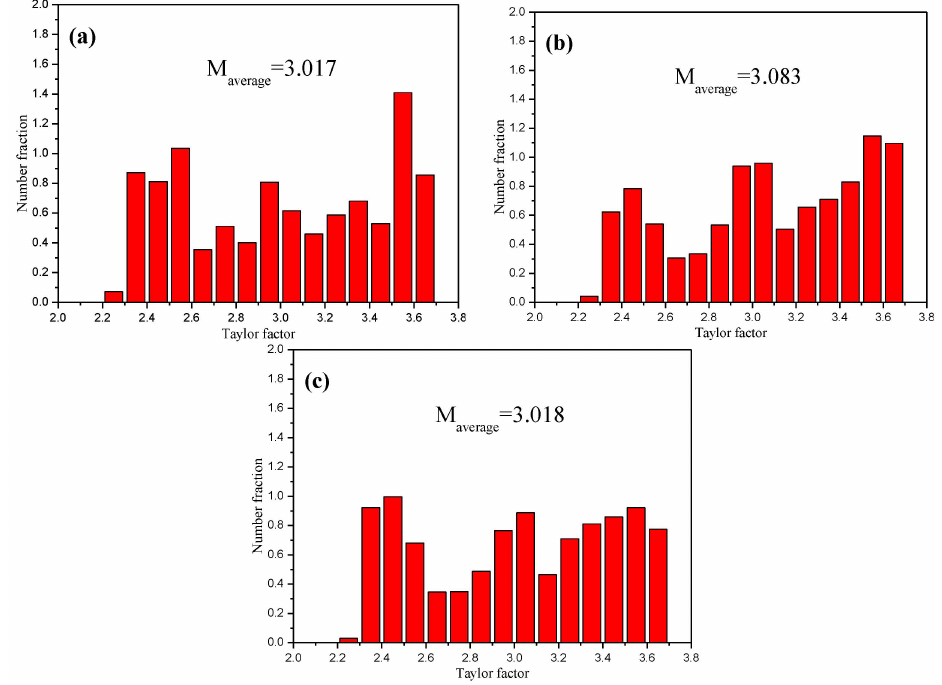
Figure 6. Taylor factor under different rolling